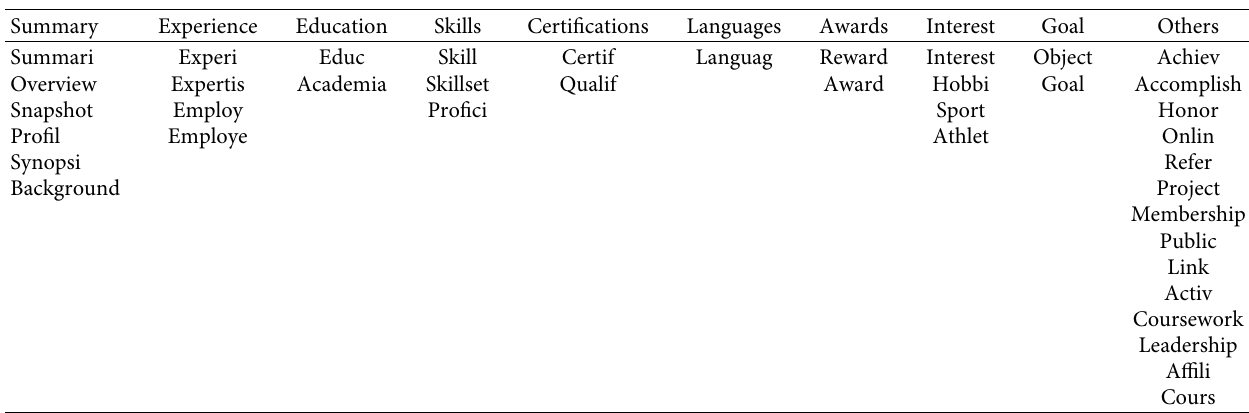
Table 2: Collection of cue words used by the